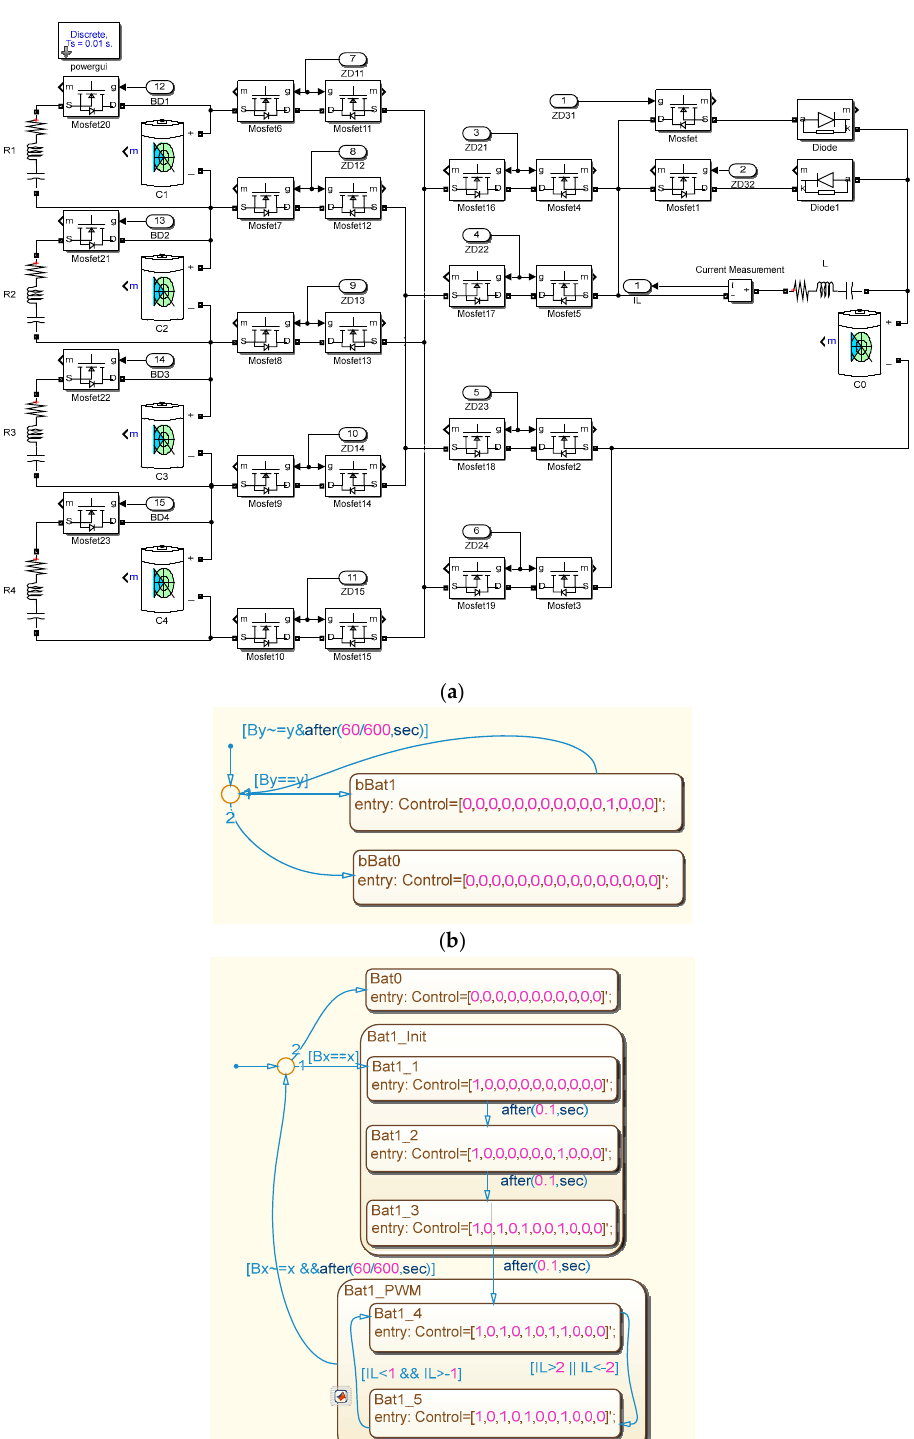
Figure 4. Simulation model of composite equalization. ( a ) Circuit configuration using Simscape in MATLAB; ( b ) passive equalization mode; and ( c ) active equalization mode.